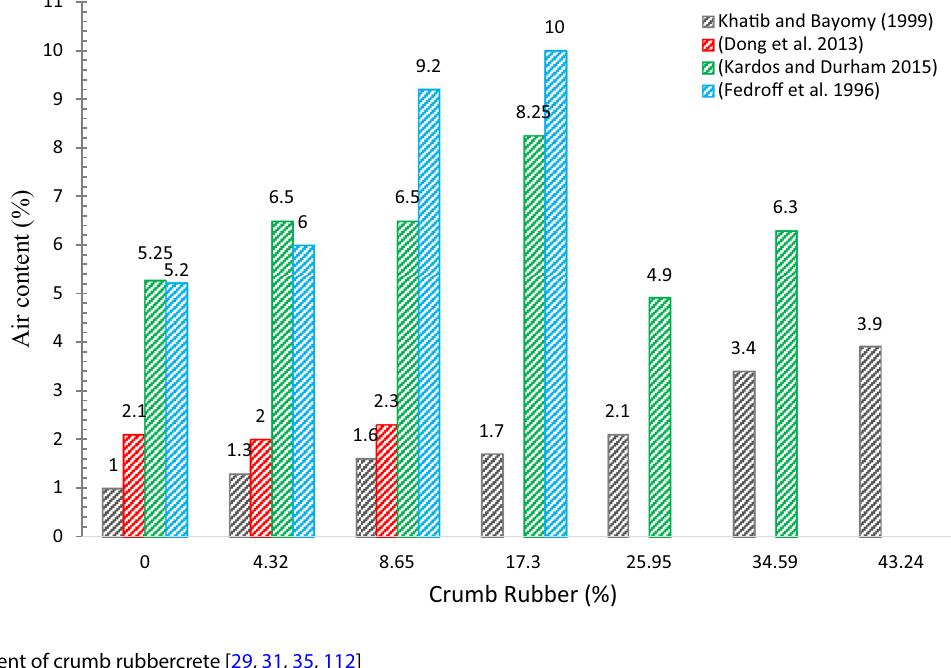
Fig. 4 Air content of crumb rubbercrete [29, 31, 35, 112]